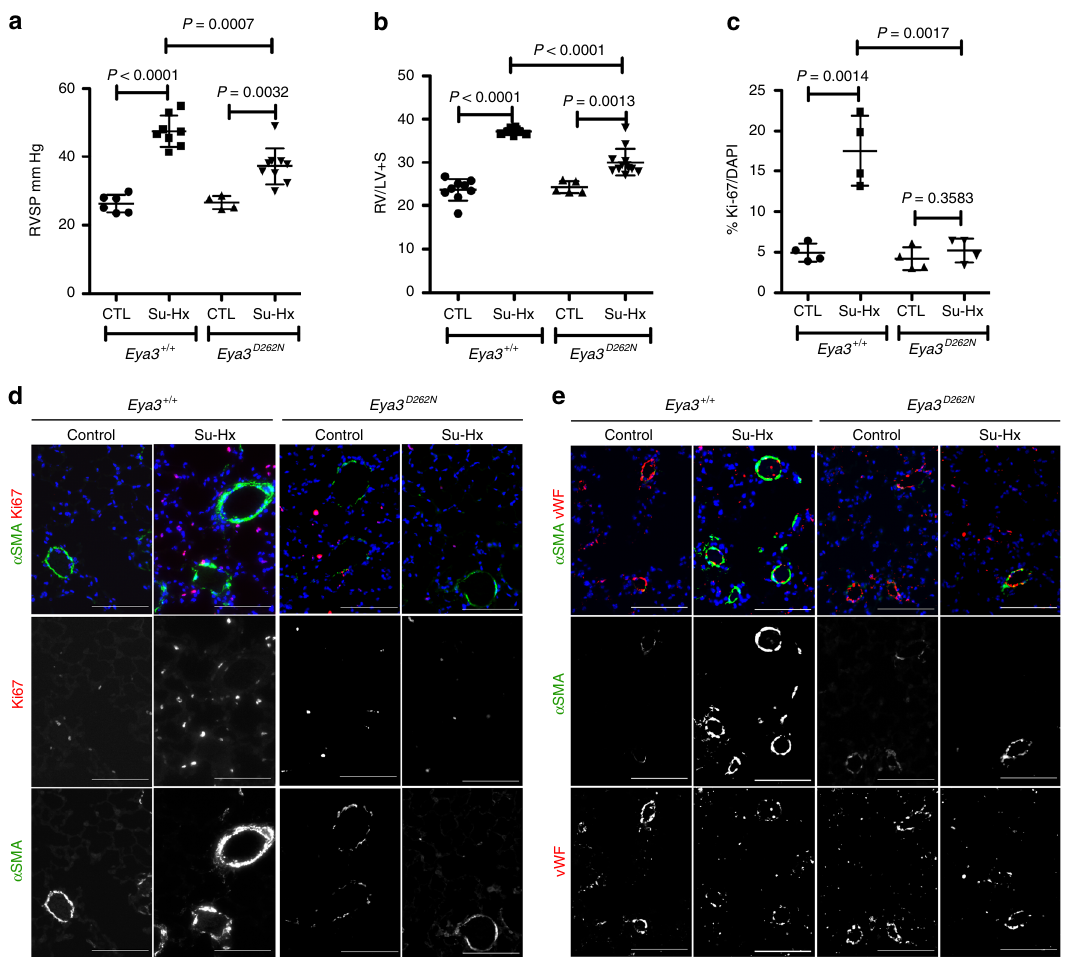
Fig. 6 Genetic loss of EYA3-PTP activity attenuates hypoxia-induced PH. a Right ventricular systolic pressure (RVSP) measured after the Sugen-hypoxia (Su-Hx) protocol is reduced in Eya3 D262N mice relative to Eya3 + / + control animals. RVSP was measured upon return to room air. Mice maintained in room air served as controls (CTL). Two independent Su-Hx experiments were conducted with a total of 21 C57BL/6J Eya3 + / + and 18 Eya3 D262N mice. RVSP measurements reported here represent successful catheterization and are plotted as the mean ± SD. Statistical signi fi cance was assessed using pairwise t -tests. b Right ventricular hypertrophy measured after the Su-Hx protocol is reduced in Eya3 D262N mice relative to Eya3 + / + control animals. Right ventricular hypertrophy (Fulton ’ s index = right ventricular (RV) weight/left ventricle (LV) + interventricular septum weight) measured upon return to room air after the Su-Hx protocol, and in mice maintained in room air for an equivalent period. Data plotted as the mean ± SD. Statistical signi fi cance was assessed using pairwise t -tests. c Quantitation of the percentage of Ki-67-positive cells. Each data point represents at least six sections per lung. For all groups n = 4. Data plotted as the mean ± SD, statistical signi fi cance determined by pairwise t -tests. d Cell proliferation and muscularization is reduced in Eya3 D262N mice subject to the Su-Hx protocol. Lung sections were stained with antibodies to α -SMA and Ki-67, and with the nuclear marker DAPI. Scale bar = 100 μ m. e Genetic loss of EYA3-PTP activity reduces muscularization of DPAs but does not affect the endothelial cell layer. Representative sections from lungs of Eya3 + / + and Eya3 D262N mice either maintained in room air or subject to the Su-Hx protocol were stained for the smooth muscle cell marker α -SMA (green), the endothelial cell marker von Willebrand factor (vWF; red), and the nuclear marker DAPI (blue). Scale bar = 100 μ m. Source Data